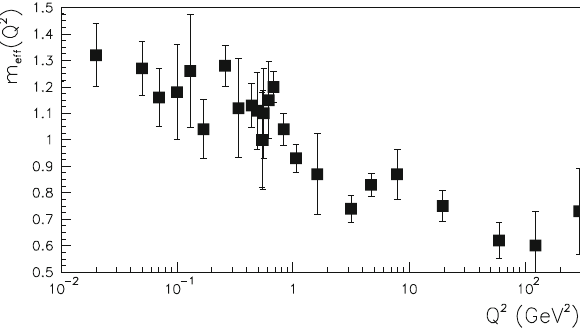
Fig. 7 The running effective mass m eff ( Q 2 ) as a function of the 4- momentum transfer Q 2 corresponding to the g 2 values shown in Fig.